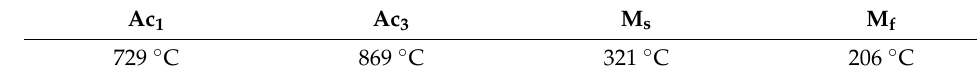
Table 2. Critical transformation temperatures measured by dilatometry.